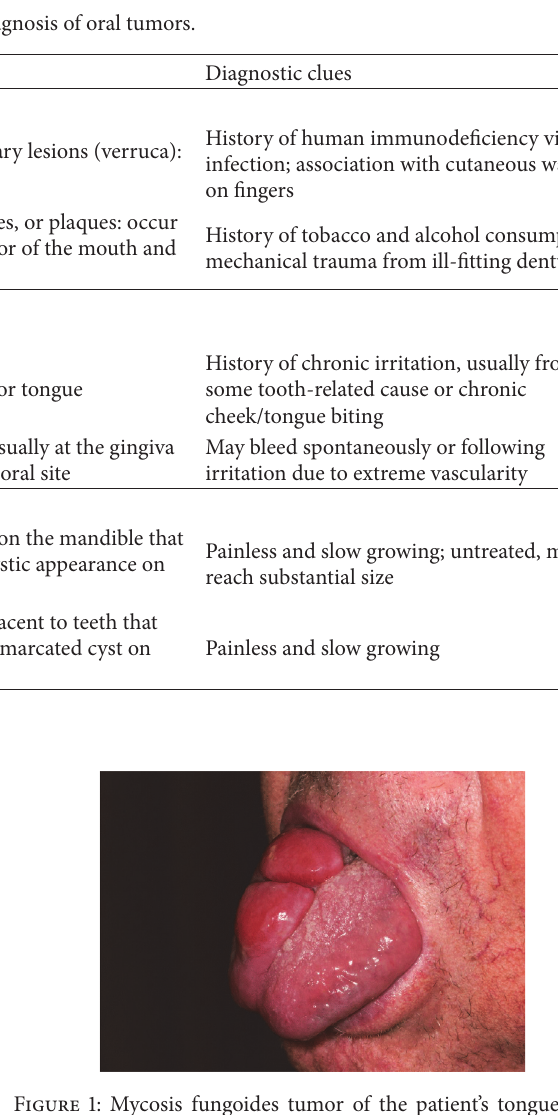
Figure 1: Mycosis fungoides tumor of the patient’s tongue mea- suring 2.0 × 2.0 × 2.5 cm with a central cleft prior to treatment. The tumor was responsive to local electron beam radiation and maintenance